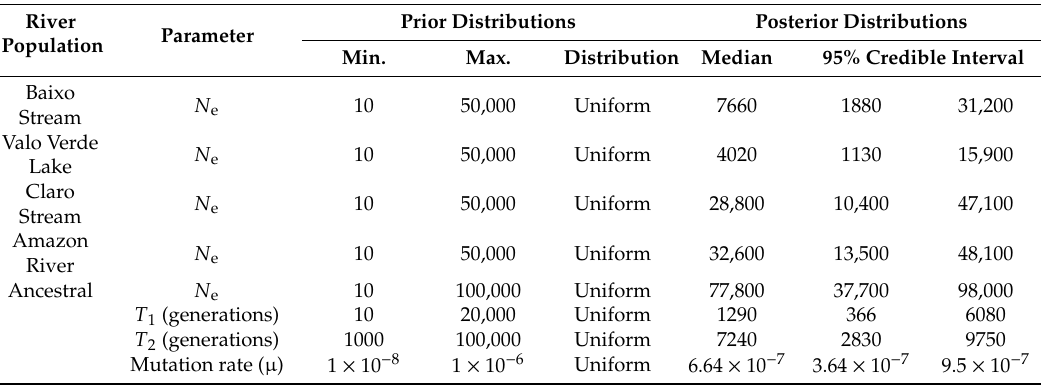
Table 3. Scenario 2 prior distributions of parameters and median posterior parameter values for populations of C. ambigua in the Amazon River and Paraguay River basins,